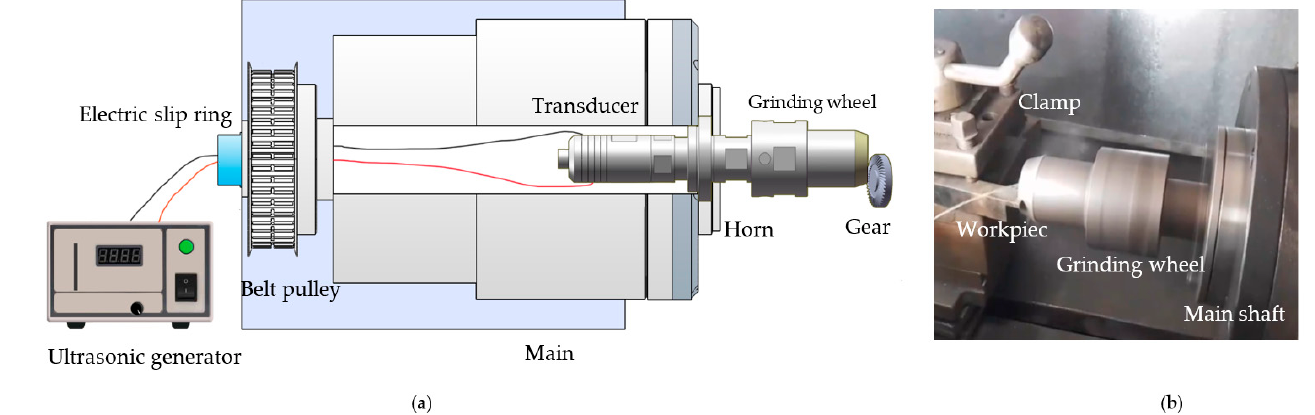
Figure 1. RUAG setup and experiment: ( a ) RUAG setup and ( b ) grinding experiment.